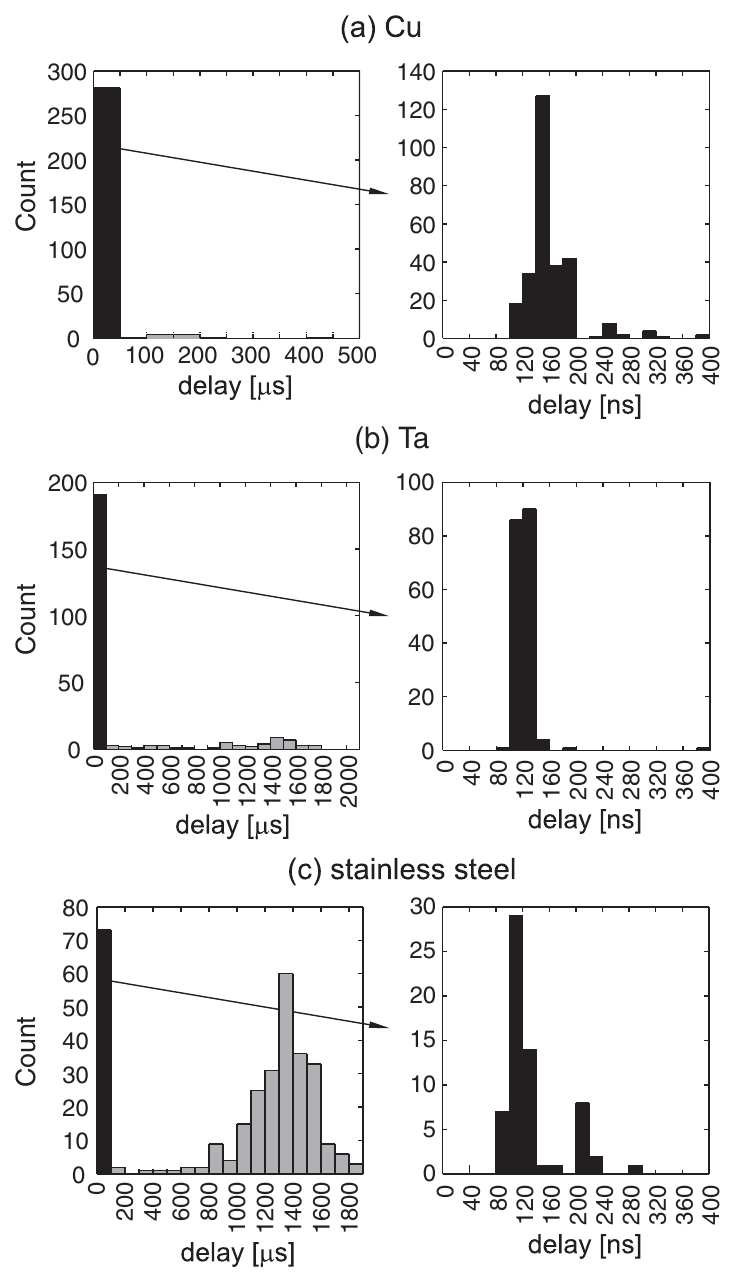
FIG. 10. Histograms of time delays with different electrode materials during conditioning experiments: (a) copper (300 breakdowns in total); (b) tantalum (250 breakdowns); (c) stainless steel (320 breakdowns). Immediate breakdowns (delays shorter than 1 (cid:2) s ) are displayed in black and are plotted with a higher time resolution on the right-hand